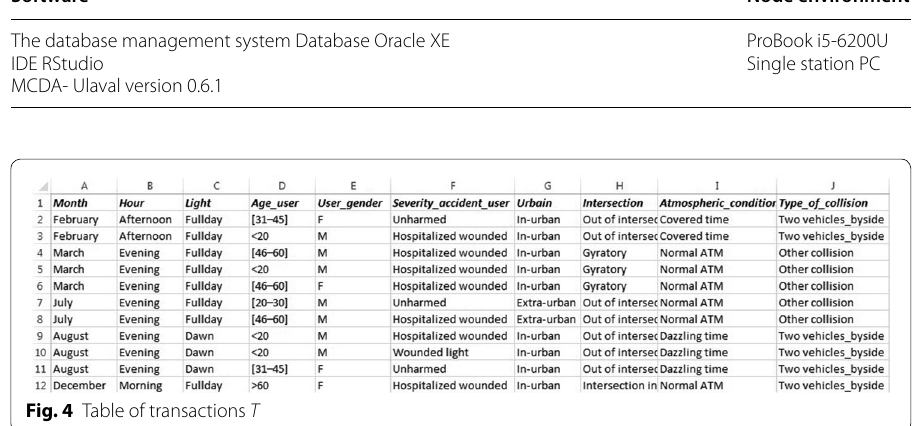
Table 3 The table of experiment environment